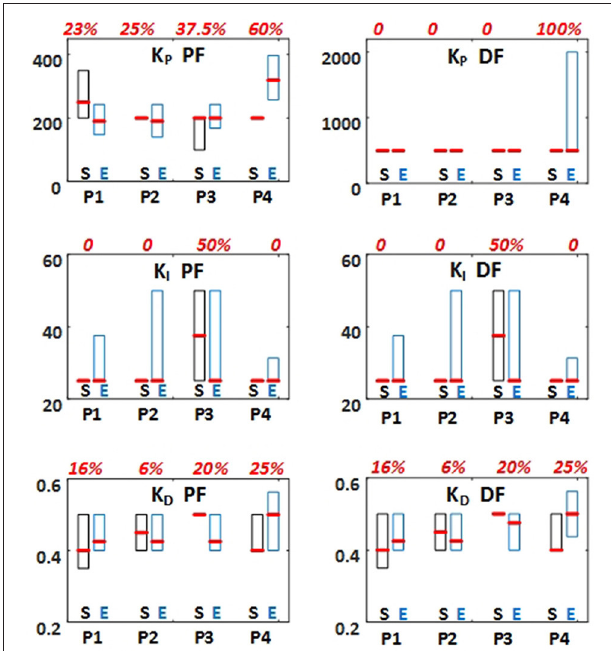
FIGURE 4 | PID controller parameters (K P , K I , and K D ) used in experiments for all test paradigms (P1–P4). The values were first suggested through simulations based on the inverted pendulum and muscle dynamics models (S: Simulation). Then, they were tuned within preliminary experiments. Finally, they were applied for the main experimental tests (E: Experiment). The results are presented as box plot indicating 25%, 50%, and 75% percentiles among all subjects. Boxplots related to simulations are shown is black and those related to experiments are shown in blue. The absolute value of the differences between the values obtained through simulation and those implemented experimentally, relative to the values obtained through simulation (in percentage) were calculated. The median of these values among the subjects are presented in red above each two simulation and experimental boxplots.